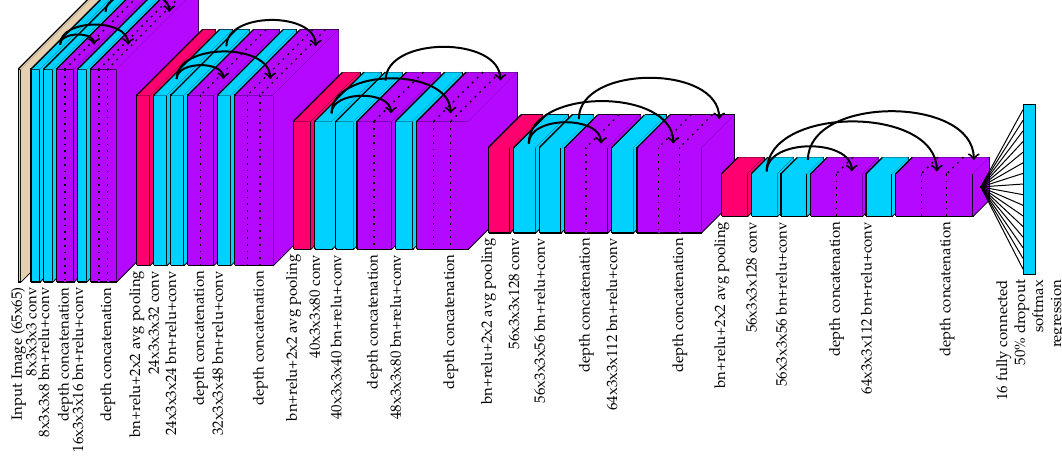
Figure 6. The deep neural network used to classify tags from 64 × 64 crops at the ear